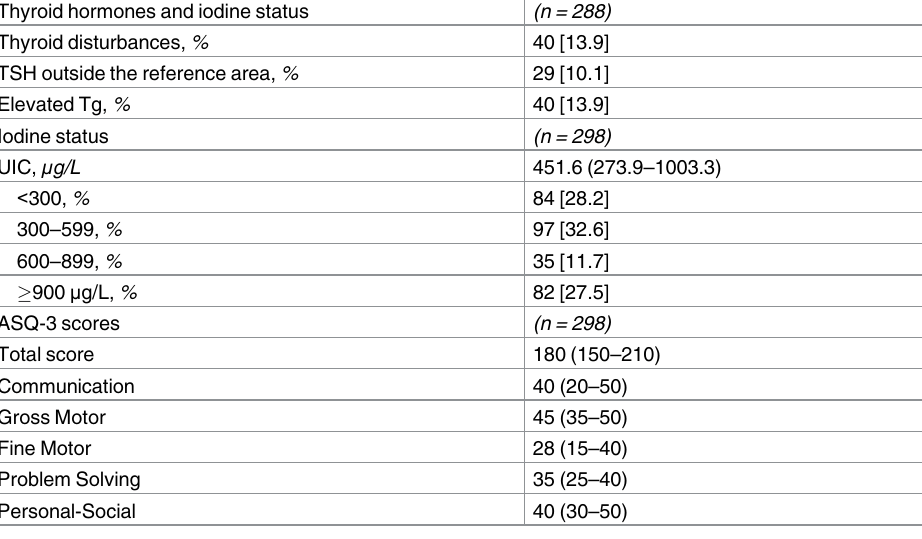
Table 2. Thyroid disturbances, iodine status and ASQ-3 scores among the children in a study describing the association between thyroid function and child development a . Thyroid hormones and iodine status (n = 288) Thyroid disturbances,